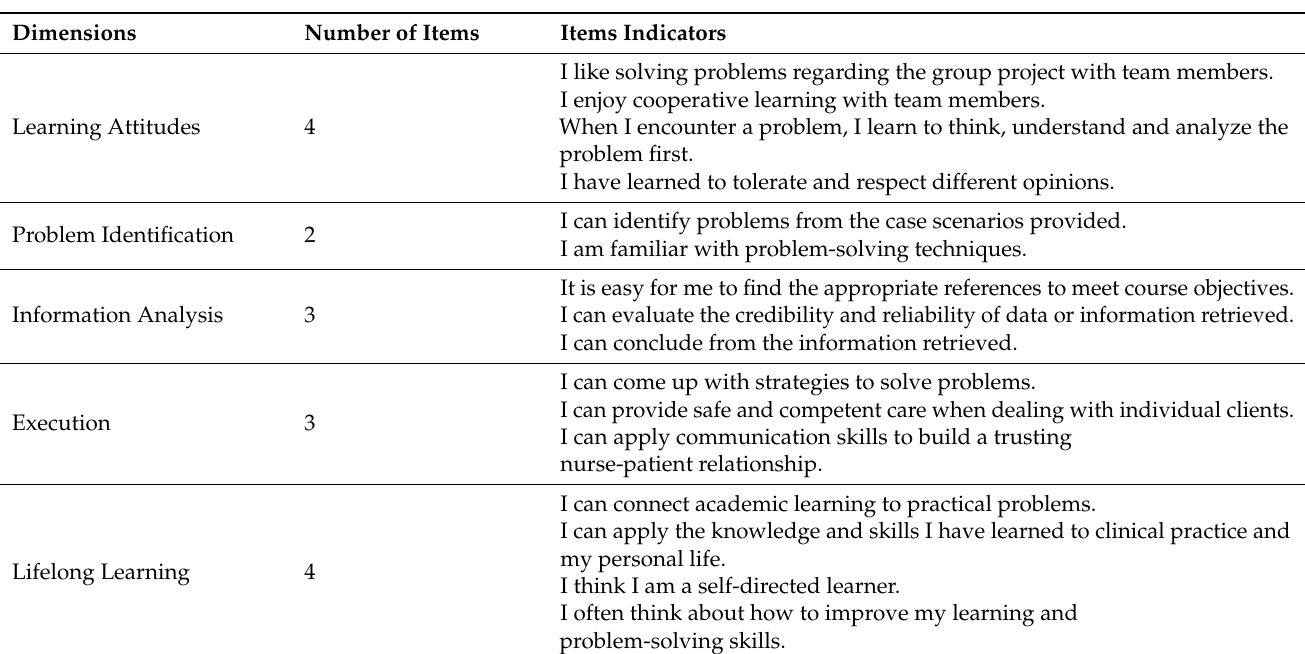
Table 1. Items analyzed in the